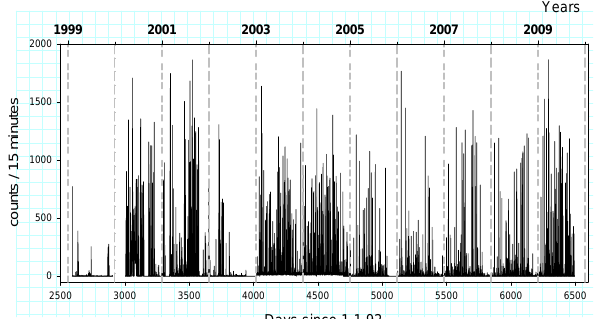
Figure 3: Time series of radon during 11-years at the Roded site showing the overall variation pattern. Intervals of very low level alternate with times of highly varying signals composed of very strong (SDR) signals. A weak annual modulation is superimposed on this pattern. Figure 4: Seven years of the radon time series at Roded shown using daily averages. The complex and intensively varying signal obliterates an underlying annual radon (AR) signal, which is traceable in the upper envelope of the variation. Smoothing the time series with a two stage sliding average (51 days and 61 days; Steinitz et al., 2007) emphasizes the AR signal and indicates also a semiannual pattern in some years.